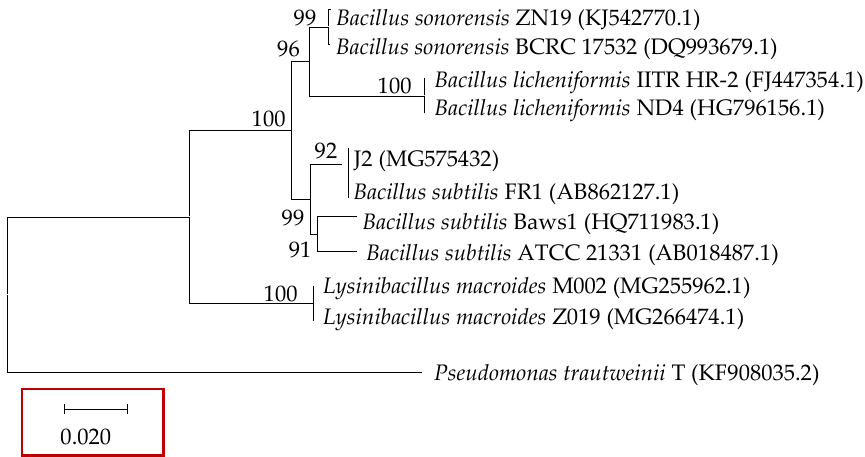
Figure 1. Phylogenetic tree of B. subtilis J2 bacterium constructed with neighbor-joining method.